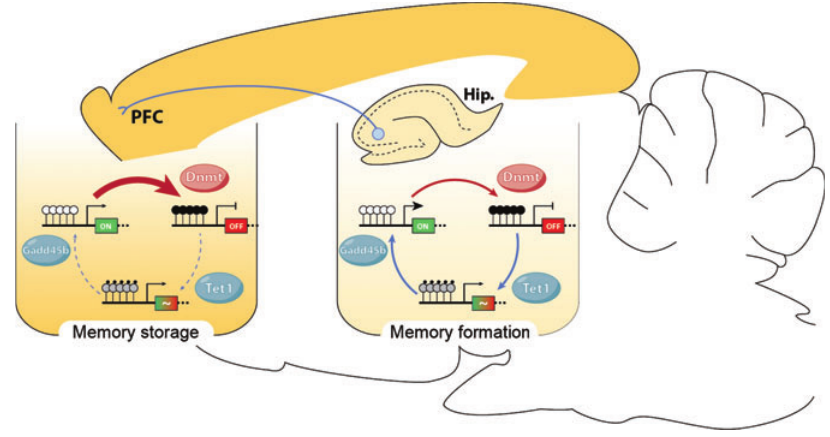
Figure 2 DNA methylation dynamics for memory formation and storage. Basal DNMT activity might be greater or directed to a specifi c subset of genes in the prefrontal cortex (PFC) to achieve a stable epigenetic land- scape required for memory storage. In the hippocampus, DNA methylation might be more dynamic with additional epigenetic players active to establish a chromatin state targeted by DNMTs and DNA ‘ demethylases ’ , leading to gene silencing and gene